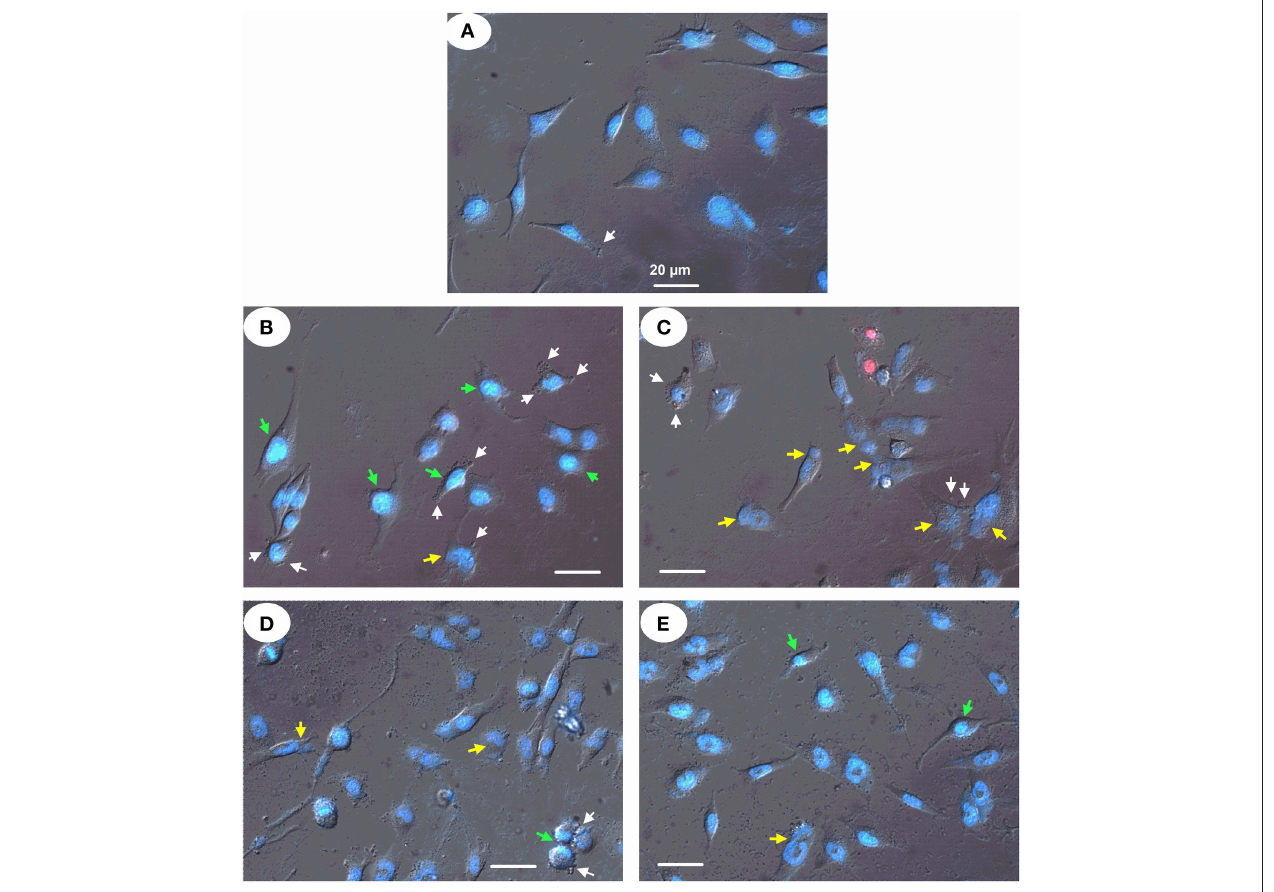
FIGURE 11 | Micrographs of human glioblastoma U251 cells treated with (B) mag.SLPs, (C) SLPs, (D) IO-OA, and (E) IO particles for 24h; (A) control. Differential interference contrast image of treated cells stained with fluorescent DNA-specific Hoechst-33342 (blue) and fluorescent DNA/RNA-specific PI (red). Yellow, green, and white arrows indicate chromatin fragmentation, its condensation, and plasma membrane blebbing, respectively. Bar corresponds to 20 µ